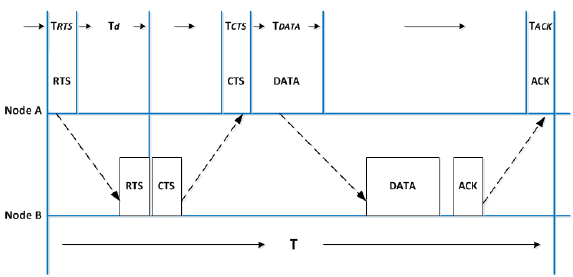
Figure 1. Handshake in terrestrial